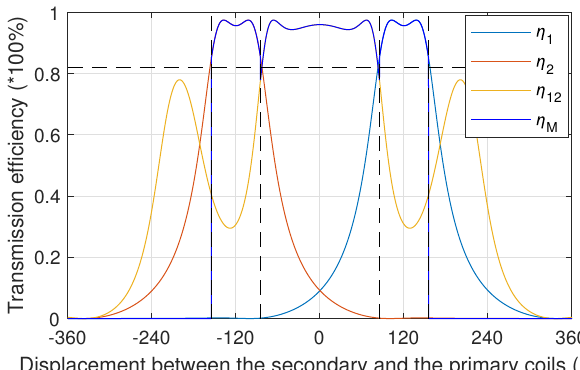
Figure 8. Adaptive working mode system transmission